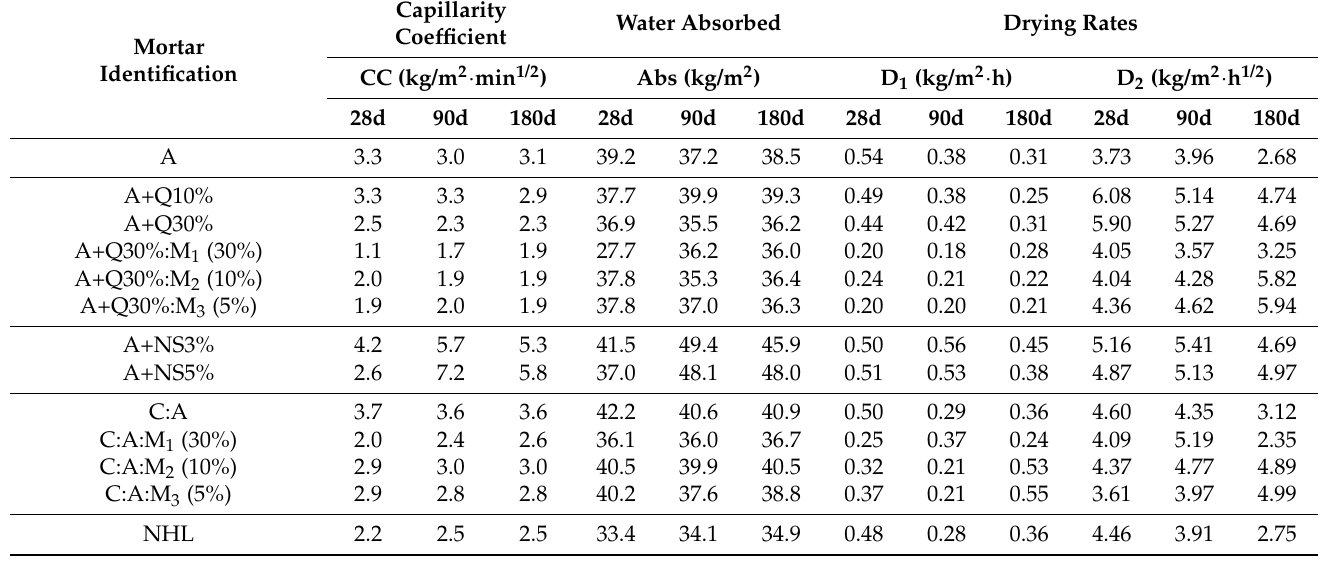
Table 5. Results of capillary water absorption and drying rates of the mortars.